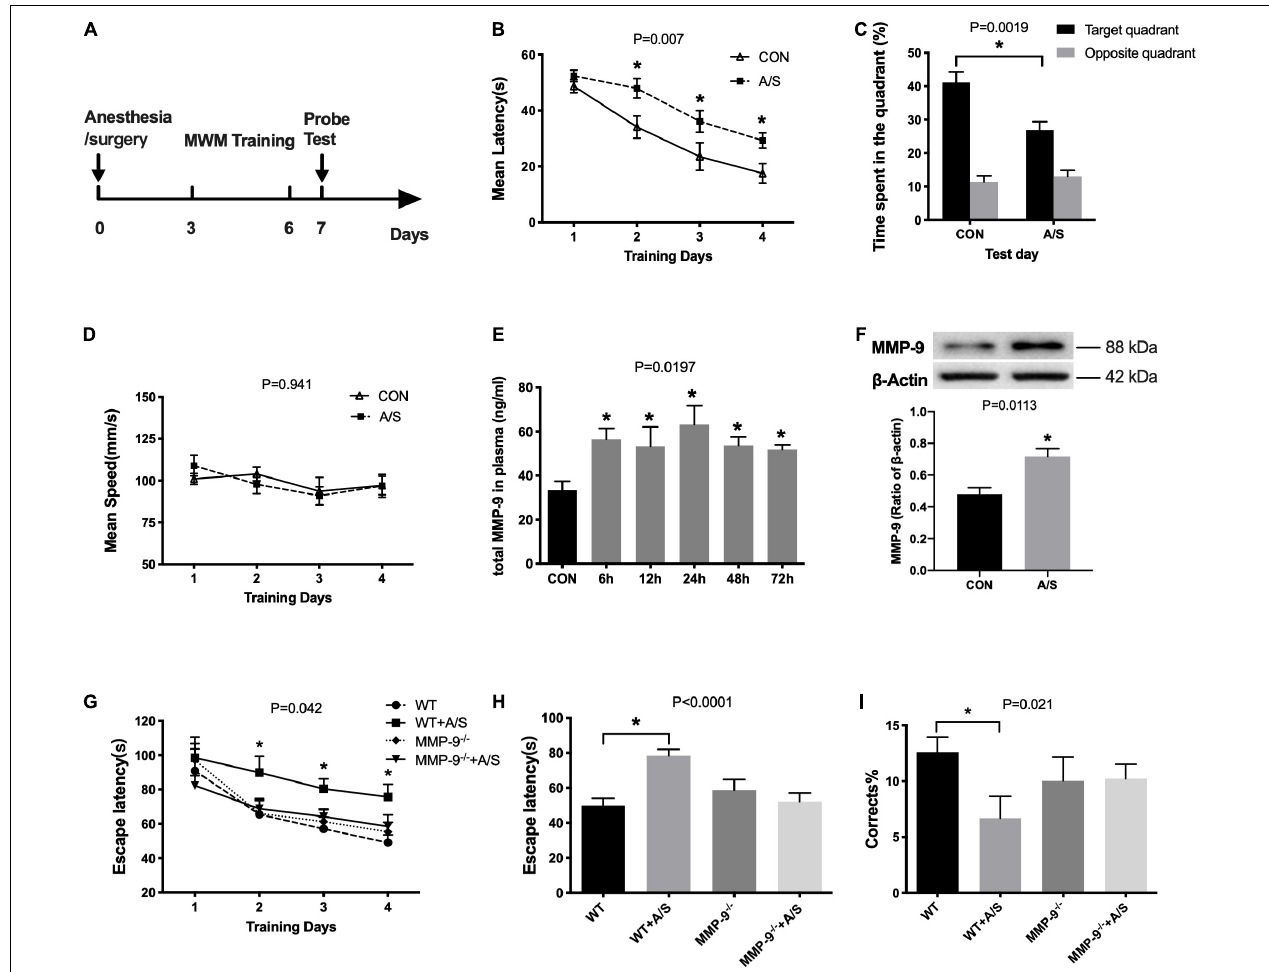
FIGURE 1 | Anesthesia/surgery–induced learning and memory dysfunction and increased MMP-9 in aged mice. (A) Schematic timeline of the MWM experimental paradigm. (B) The mean escape latency in the anesthesia/surgery (A/S) group increased significantly on the second, third, and fourth days when compared with that in the control (CON) group during training days, F ( 1 , 22 ) = 8.808, P = 0.007. (C) In the anesthesia/surgery group, the time spent in the target quadrant was shorter than in the control group in the probe test section, P = 0.0019. (D) There was no difference between the two groups in the average swimming speed, F ( 1 , 22 ) = 0.674, P = 0.941. ( n = 12 per group in water maze). (E) Total MMP-9 in plasma was increased as early as 6 h after anesthesia/surgery until 72 h, F ( 5 , 31 ) = 3.181, P = 0.0197. (F) Anesthesia/surgery significantly increased the MMP-9 levels in the hippocampus as compared with the control group, P = 0.0113. ( n = 4–7